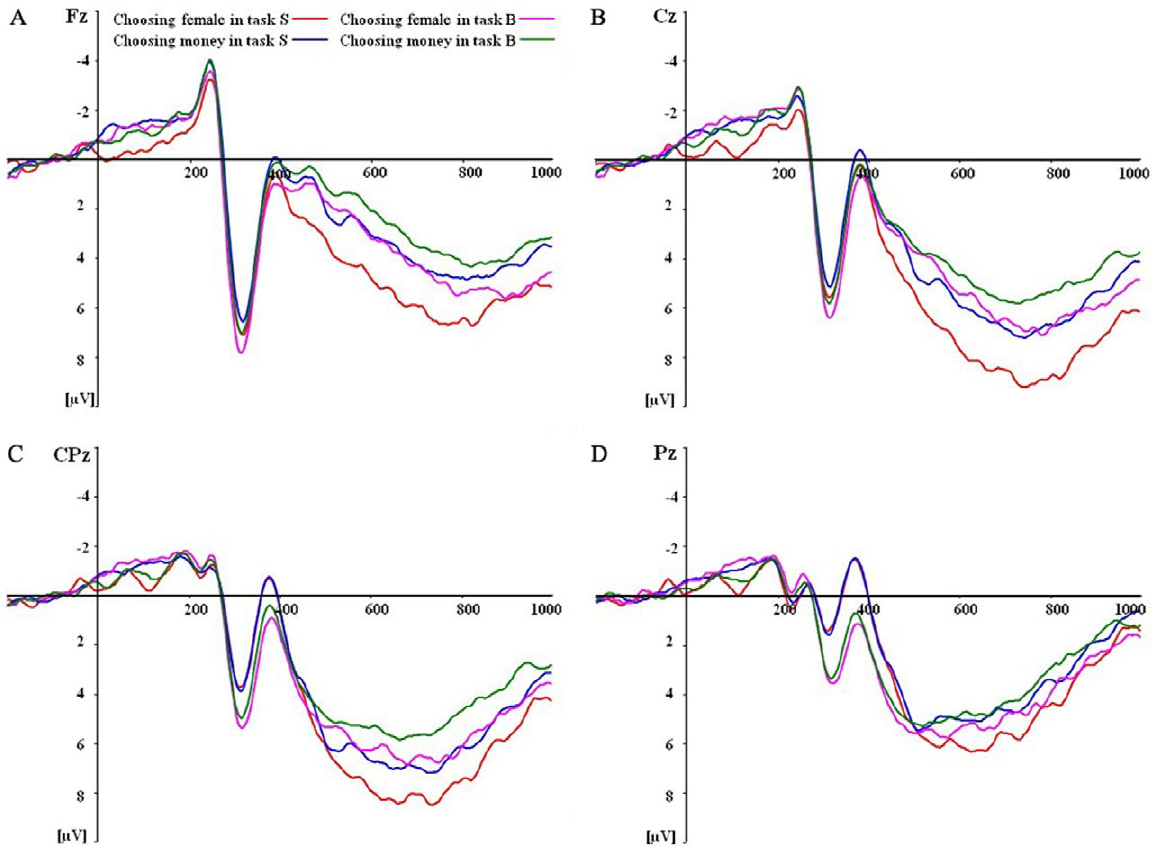
Figure 2. Grand average ERPs in the decision-making phase. Grand average ERPs of the four conditions at Fz, Cz, CPz and Pz electrode points when subjects made decisions.